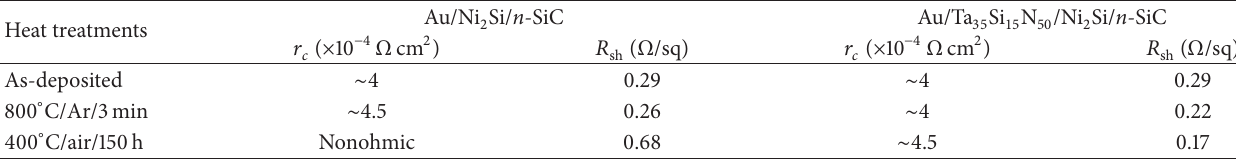
Table 5: Electrical properties of Au/Ni 2 Si/ n -SiC and Au/Ta 35 Si 15 N 50 /Ni 2 Si/ n -SiC ohmic contacts versus heat